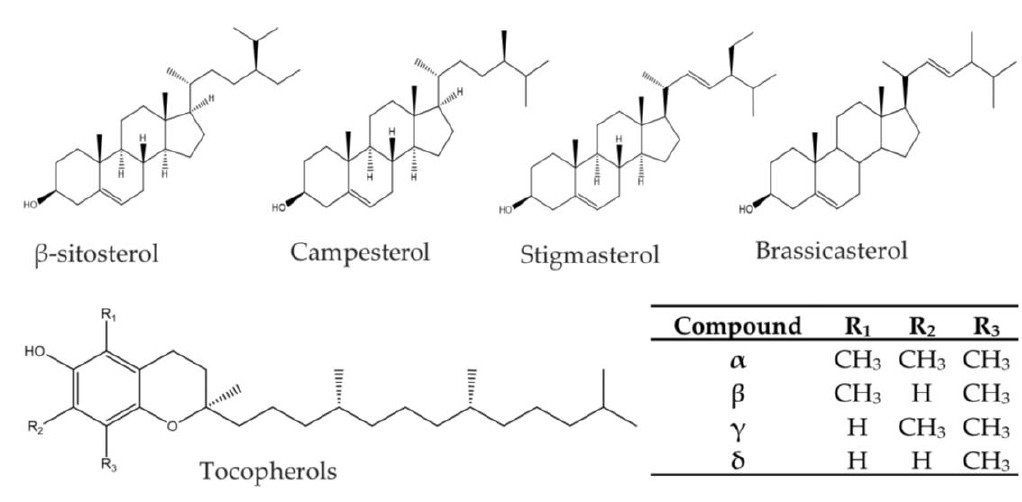
Figure 1. Structures of abundant phytosterols and tocopherols ( α -alpha, β -beta, γ -gamma, and δ -delta). To avoid derivatization, liquid chromatography-mass spectrometry (LC-MS) has been adapted. Ionization at atmospheric pressure is employed and both electrospray ionization (ESI) and atmospheric pressure chemical ionization (APCI) have been used for the